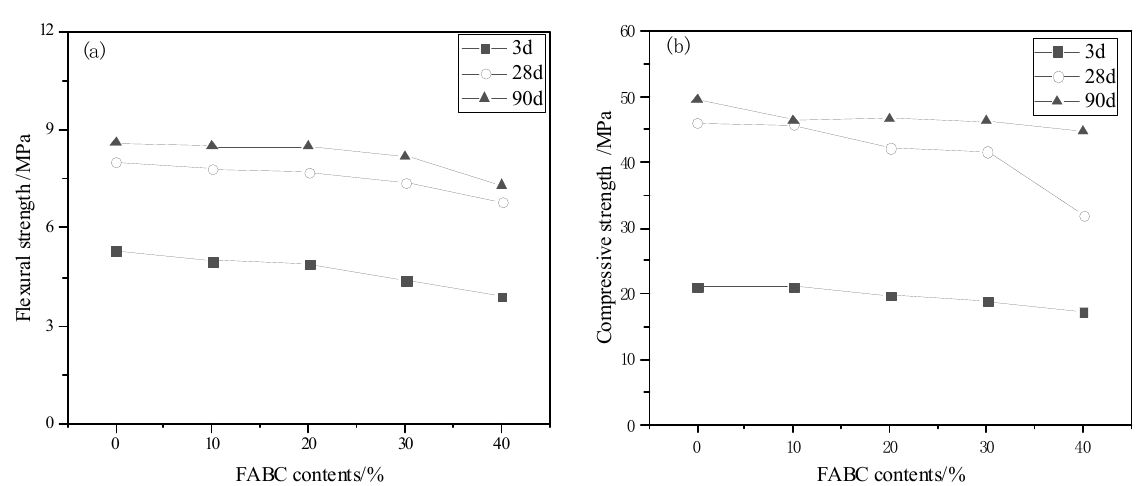
Figure 4. The strength of mortars with different FABC content: ( a ) Flexural strength; ( b ) Compressive strength.